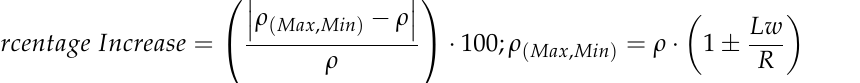
Figure 7. Multidimensional arrays and commands for array indexing.